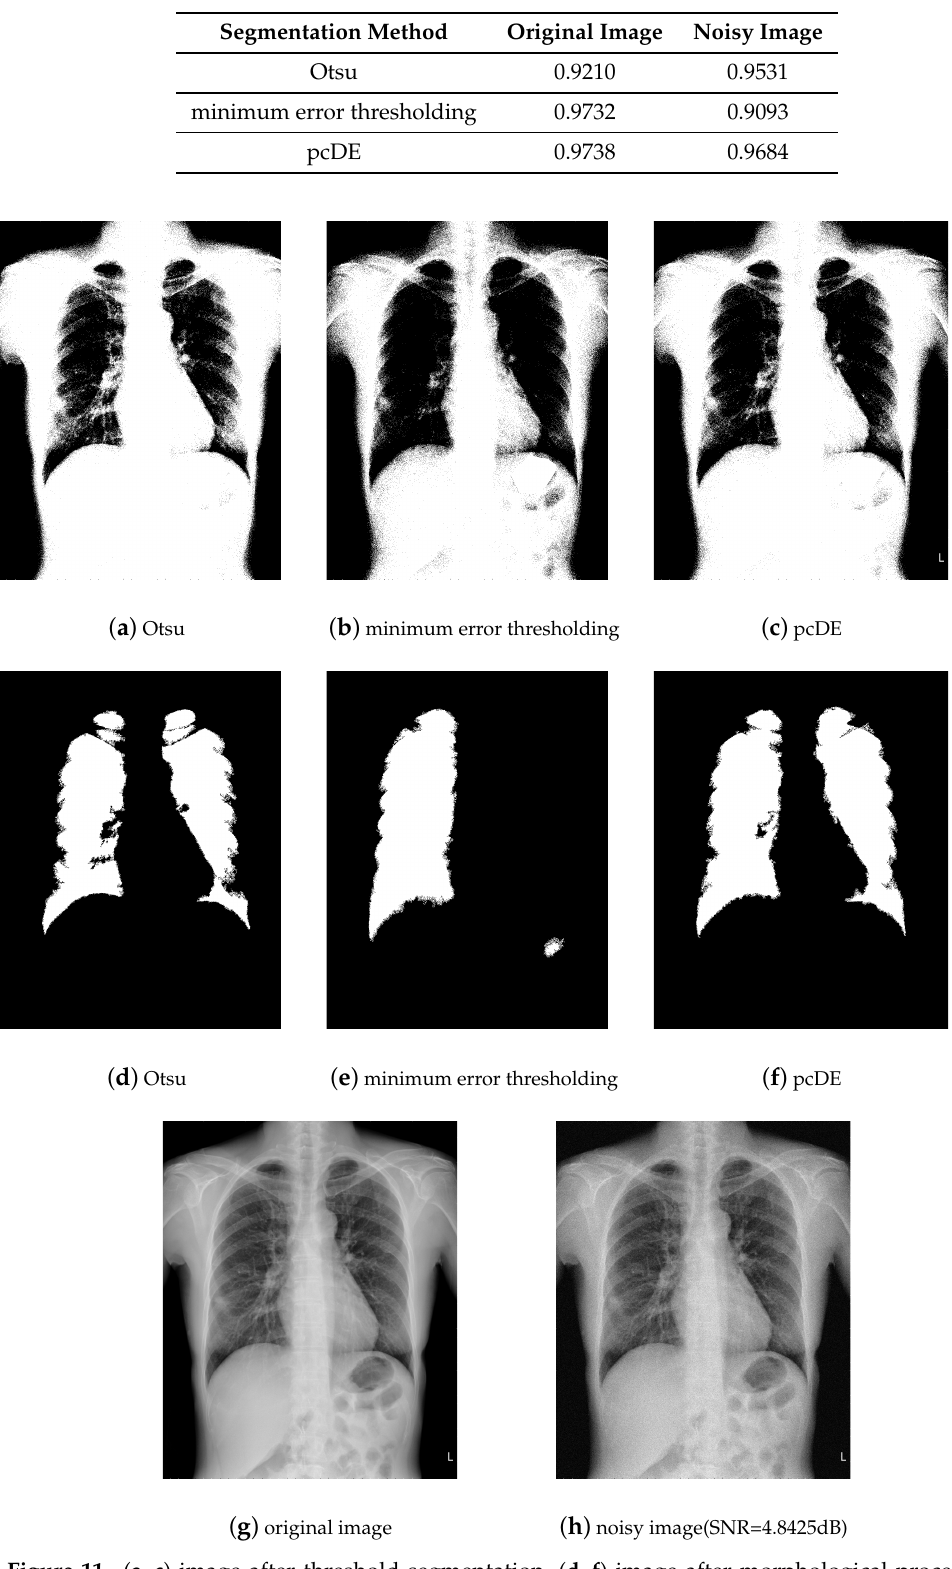
Figure 11. ( a – c ) image after threshold segmentation, ( d – f ) image after morphological processing, ( g ) original image, ( h ) noisy